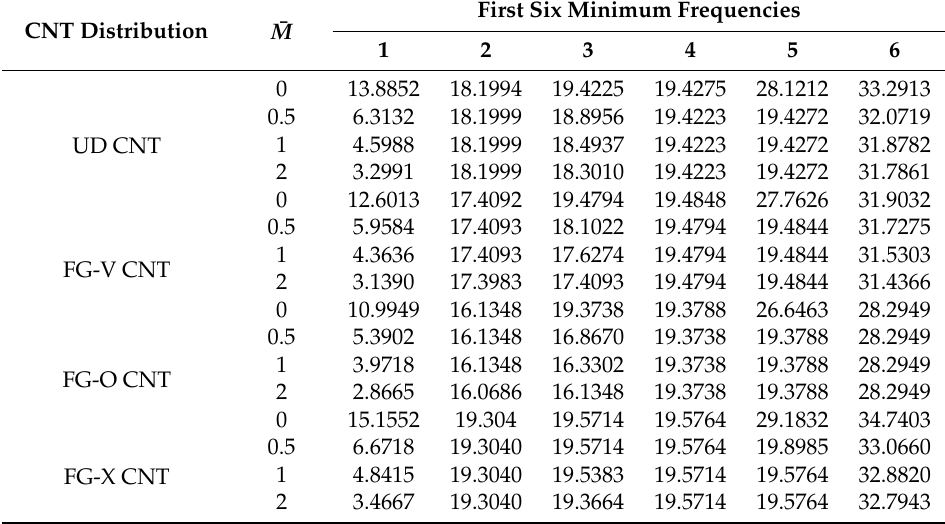
(cid:0) = 0.11, a / h = 10 (cid:1) . V ∗ CNT